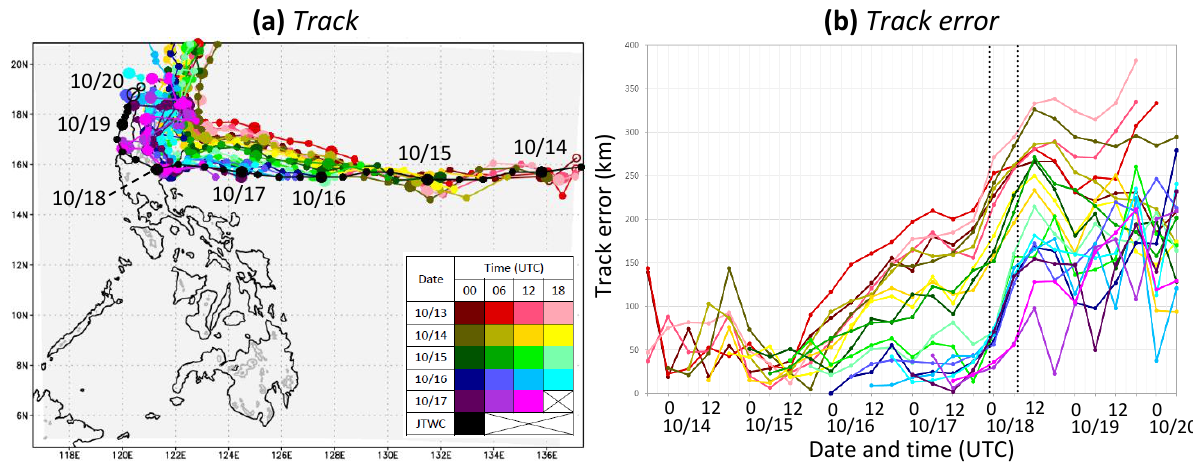
Figure 6. As in Figure 2, but for ( a ) the tracks and ( b ) track errors of TY Koppu (2015) by the time-lagged forecasts, against the JTWC best track.